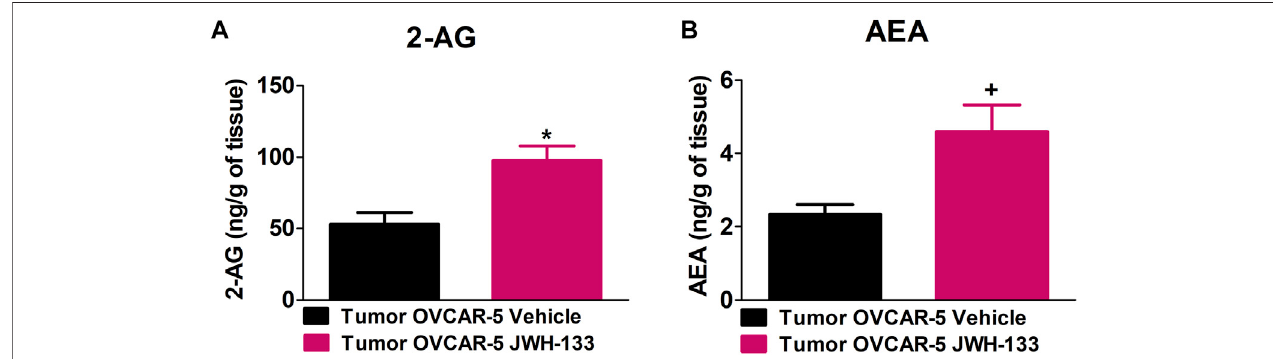
FIGURE5| Increasein2-arachidonoylglycerol(2-AG)andanandamide(AEA)levelsintheOVCAR-5ectopicxenografttumorsofSCID-SHOfemalemicereceiving chronic systemic administration of JWH-133. JWH-133 (1 mg/kg i.p.) chronic administration for 30 days starting on day 30 of tumor growth produced an increase in 2- AG (A) and AEA (B) levels in the OVCAR-5 ectopic xenograft tumors of SCID-SHO female mice relative to the vehicle treated group. Symbols represent the means ± SEM. (OVCAR-5 tumors in SCID-SHO female mice receiving vehicle, n = 5 SCID-SHO females; OVCAR-5 tumors in SCID-SHO female mice receiving JWH-133,